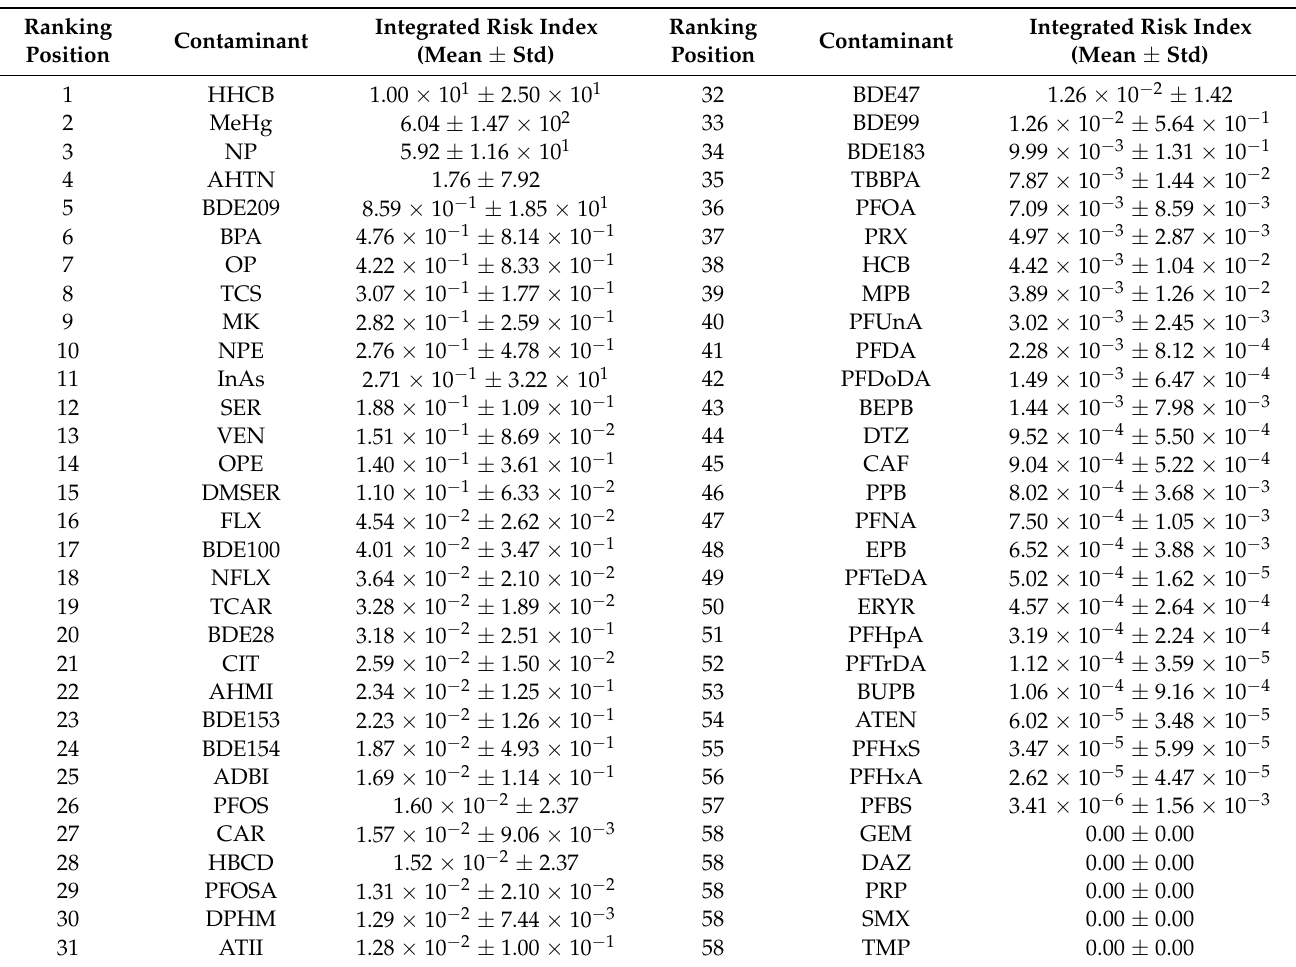
Table 3. Ranking of emerging contaminants based on mean (50 percentile) integrated risk rank (IRI) score considering the persistence, bioaccumulation, toxicity (PBT) parameters and concentration levels in seafood. Ranking